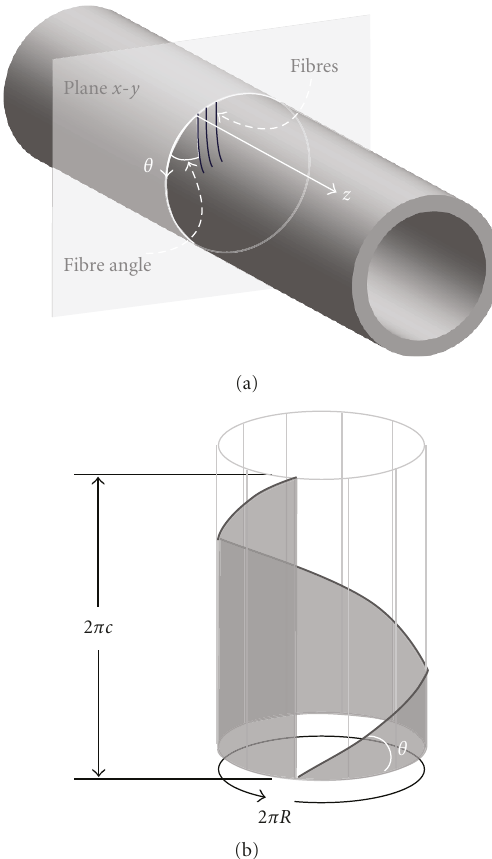
Figure 2: (a) Convention for the lead fibre angles calculated in this study; (b) definition of the fibre